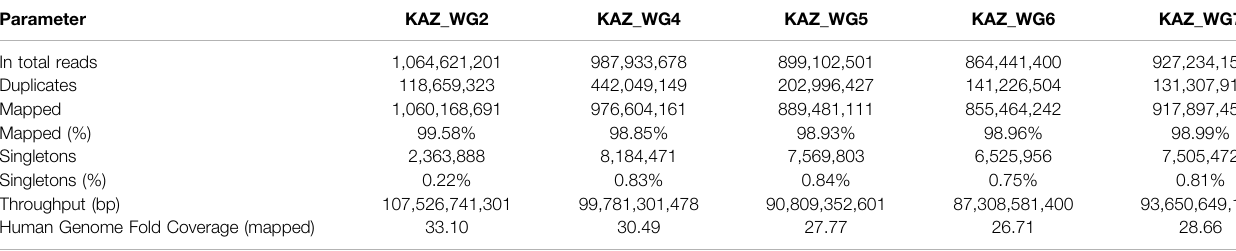
TABLE 1 | Alignment statistics of whole-genome sequencing of Kazakh individuals.